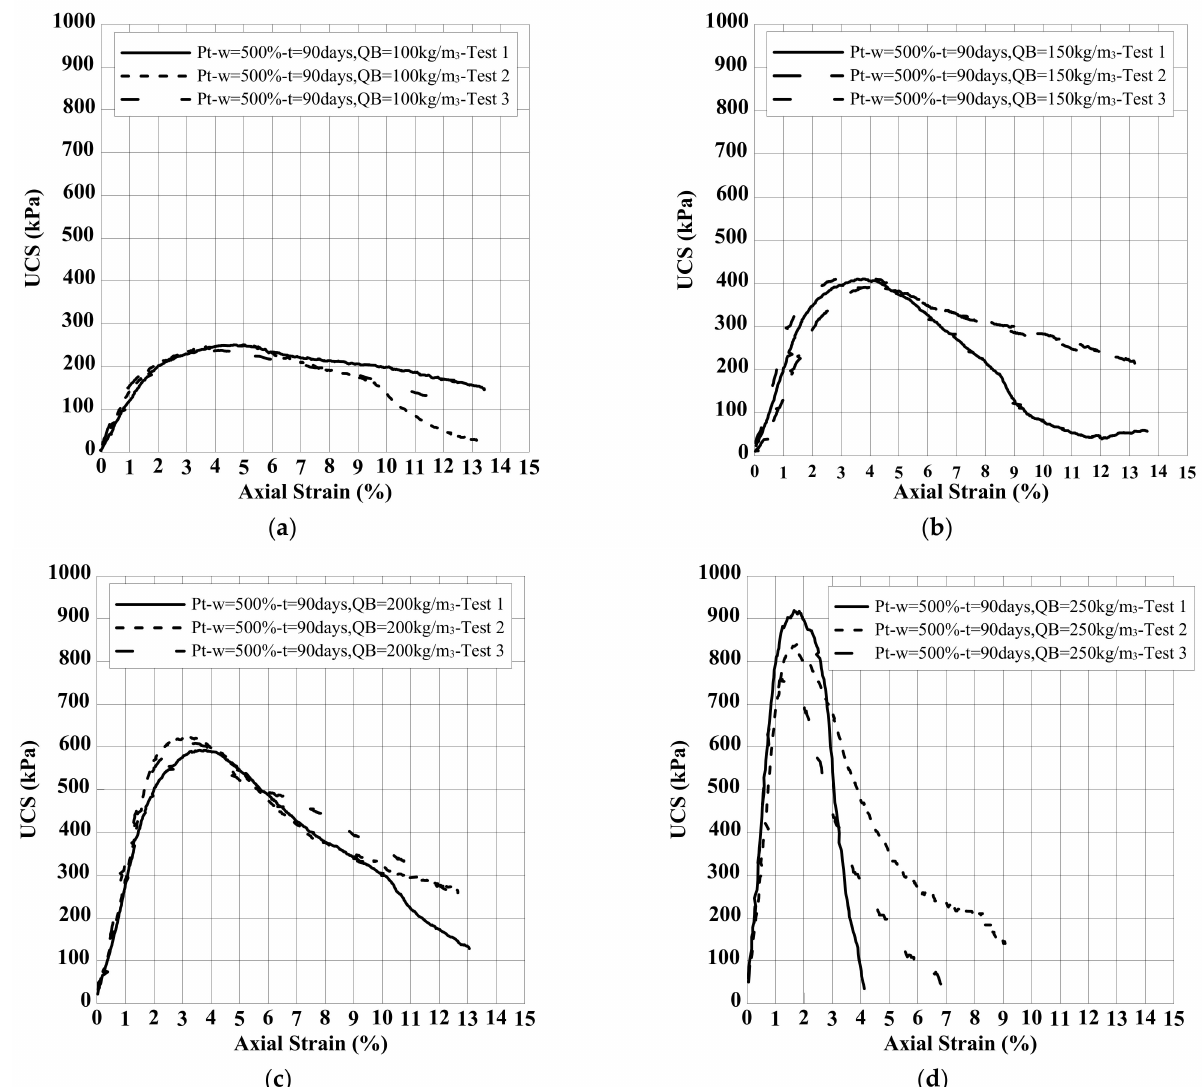
Figure 5. Axial stress–strain curves showing testing repeatability for Pt - PC -w = 500%-t = 90 days; ( a ) QB = 100 kg/m 3 ; ( b ) QB = 150 kg/m 3 ; ( c ) QB = 200 kg/m 3 ; and ( d ) QB = 250 kg/m